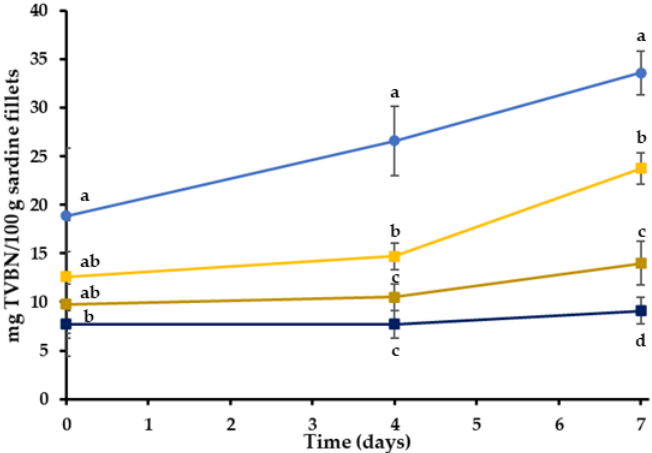
Figure 4. Total volatile basic nitrogen (TVBN) in the treatment during chilled storage (4 °C). Results have been expressed as mg of TVBN per 100 g of sardine fillets. ( ● ) C: control-uncoated fillets; ( ■ ) BG: bigel coating; ( ■ ) BGHR: bigel coating with added RE in the aqueous phase; ( ■ ) BGOR: bigel coating with added RE in the lipid phase. a – d Different letters in the same day indicate significant differences ( p < 0.05).